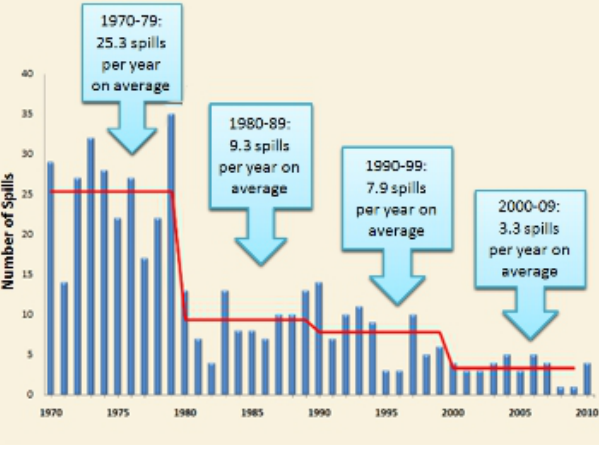
Fig. 1 . Number of marine oil spills worldwide over 700 metric tonnes from